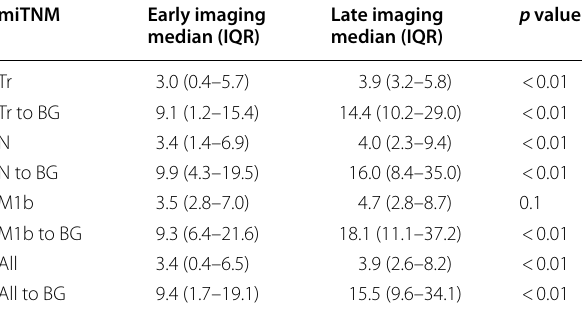
Table 3 SUVmax and SUVmax to background values